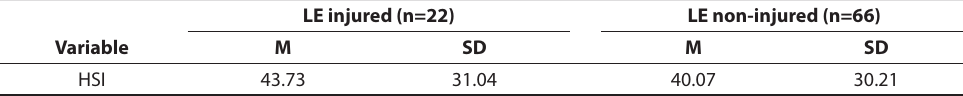
TABLE 2 Average mean (±SD) values for Injured and non-injured players in maximum eccentric peak